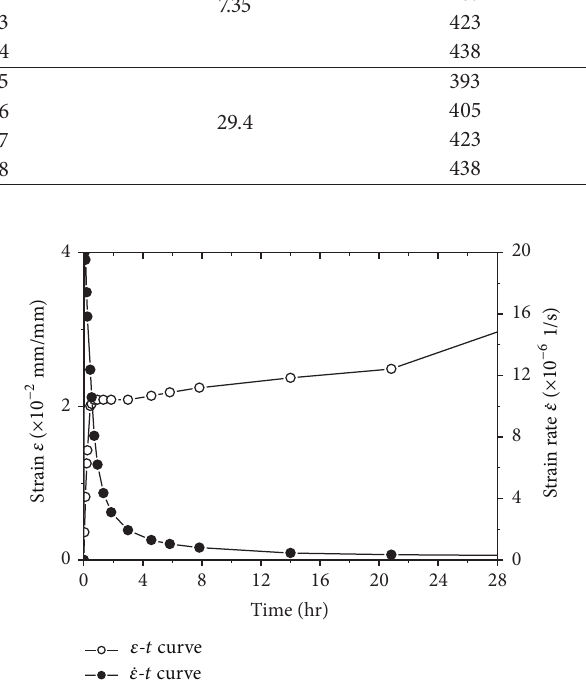
Figure 5: Correlation of strain-time and strain rate in the tensile creep experiment under a temperature of 438 K and a load of